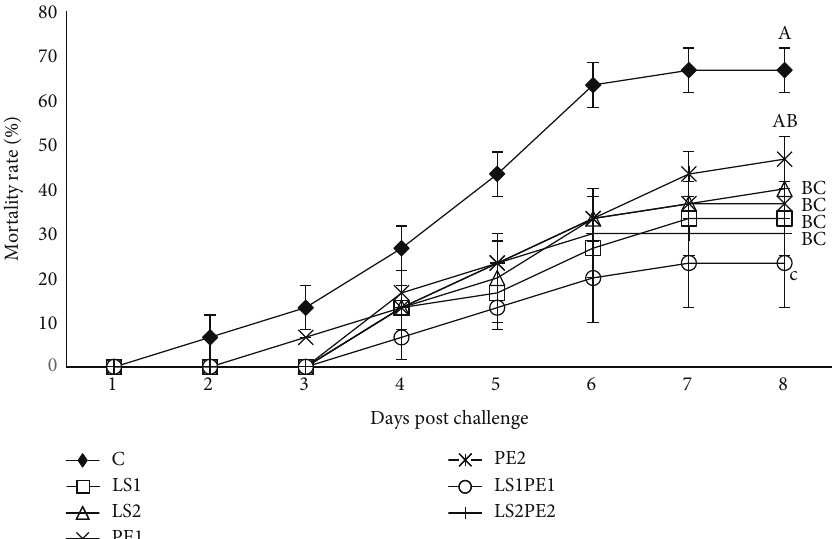
Figure 4: Mortality rate of cray fi sh narrow-clawed cray fi sh ( P. leptodactylus ) fed with basal diet and supplemented with LS1 ( L. salivarius , 1 × 10 7 CFU/g), LS2 ( L. salivarius , 1 × 10 9 CFU/g), PE1 (Pectin, 5 g/kg), and PE2 (Pectin, 10 g/kg), LS1PE1 ( L. salivarius , 1 × 10 7 CFU/g +Pectin. 5g/kg) and LS2PE2 ( L. salivarius , 1 × 10 9 CFU/g +Pectin, 10g/kg) for 18 weeks. Bars represent the mean ± SD ( n = 3 ). Di ff erent superscripts show signi fi cant di ff erences between the experimental